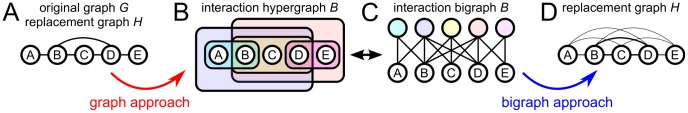
Modeling population structures in evolutionary multiplayer games.The graph approach consists in first defining the original graph  (Panel A) and then constructing the interaction hypergraph  (Panel B) by associating a hyperedge with each closed neighborhood in . The interaction hypergraph can be also represented as a bigraph (Panel C), where individuals/players are bottom vertices and groups/games are top vertices. In the graph approach the replacement graph  is assumed to be equal to the original graph , so that interactions take place along the hyperedges of the hypergraph, but strategy updating occurs along the edges of the original graph. The alternative bigraph approach consists in first defining the interaction bigraph  (Panel C) and then obtaining the replacement graph  (Panel D) as the bottom projection of the interaction bigraph. Weights can be attached to the links of the replacement graph according to different heuristics (here, the “unnormalized weighted projection” method is used; the width of the links is proportional to the links’ weights). The interaction bigraph can be constructed from a bipartite graph model or following the graph approach from a simple graph  (Panel A). In this last case, the replacement graphs due to the graph approach (the original graph shown in Panel A) and to the bigraph approach (the projection of the interaction bigraph shown in Panel D) differ, the latter being denser.